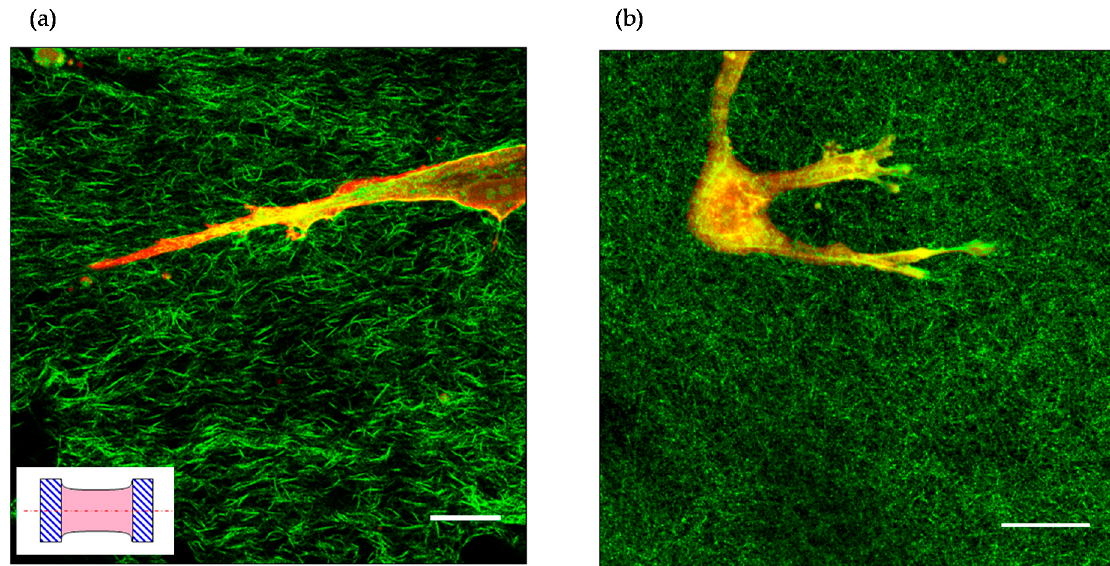
Figure 4. Cells encapsulated in type I collagen gel. Bovine dermal fibroblasts cultivated for one week in 2.4 mg/mL collagen gel. ( a ) In uniaxial constrained gels, cell-generated forces cause the gel to compact in the two free directions (orthogonal to the constraints; see the inset). Upon compaction, collagen fibrils result in being aligned and cells are elongated. ( b ) In free floating gels, extensive collagen densification is observed around cells, which possess a dendrite-like morphology. Collagen (green) is observed in reflection mode. Cells are stained for actin (TRITC-phalloidin). Bar = 20 µm.